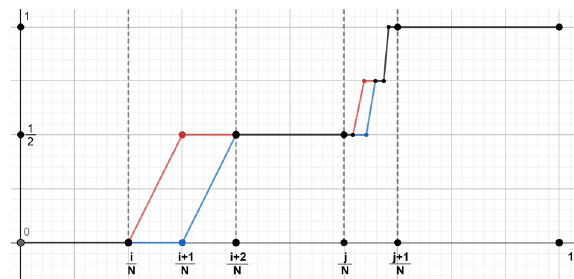
( blue ) and F ( red ) . C → B →